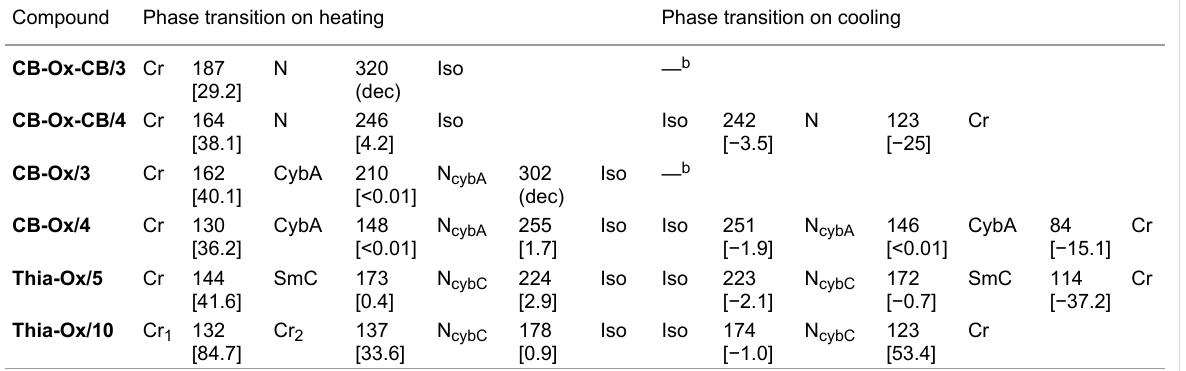
Table 1: Phase-transition temperature ( T /°C) and associated enthalpy values (in square brackets, Δ H /kJ mol − 1 ) of the synthesized di- and trimeso- gens. a Compound